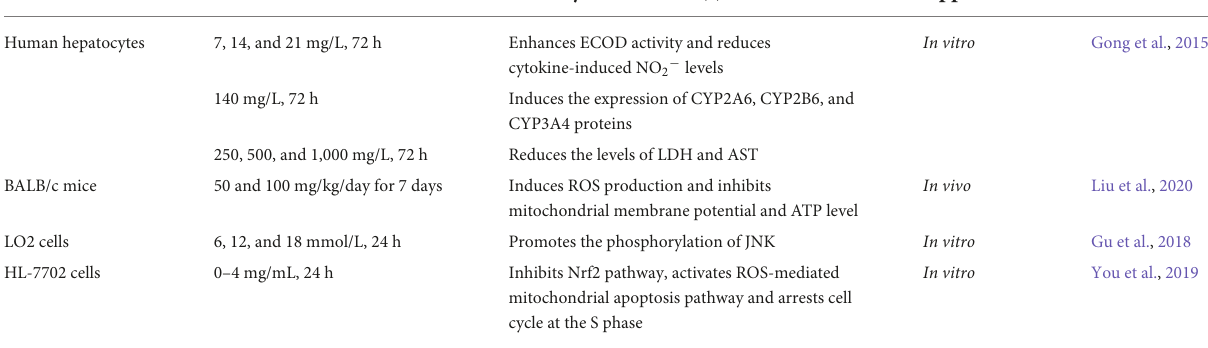
TABLE 2 Toxicity of